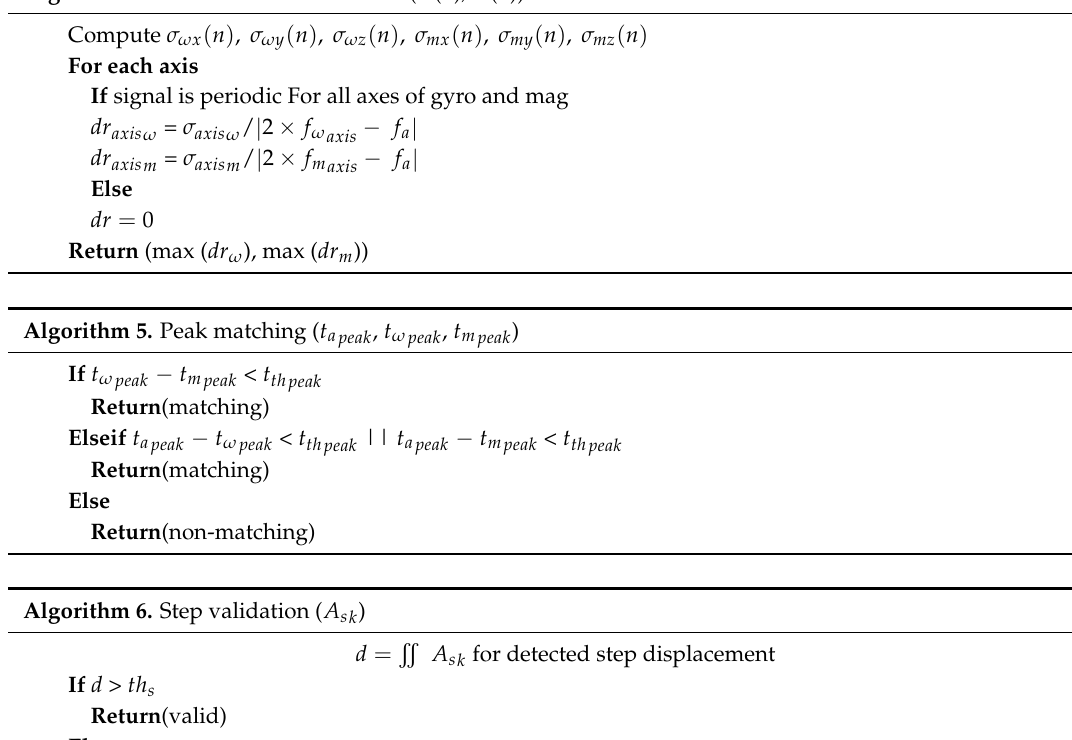
Algorithm 6. Step validation ( A sk )